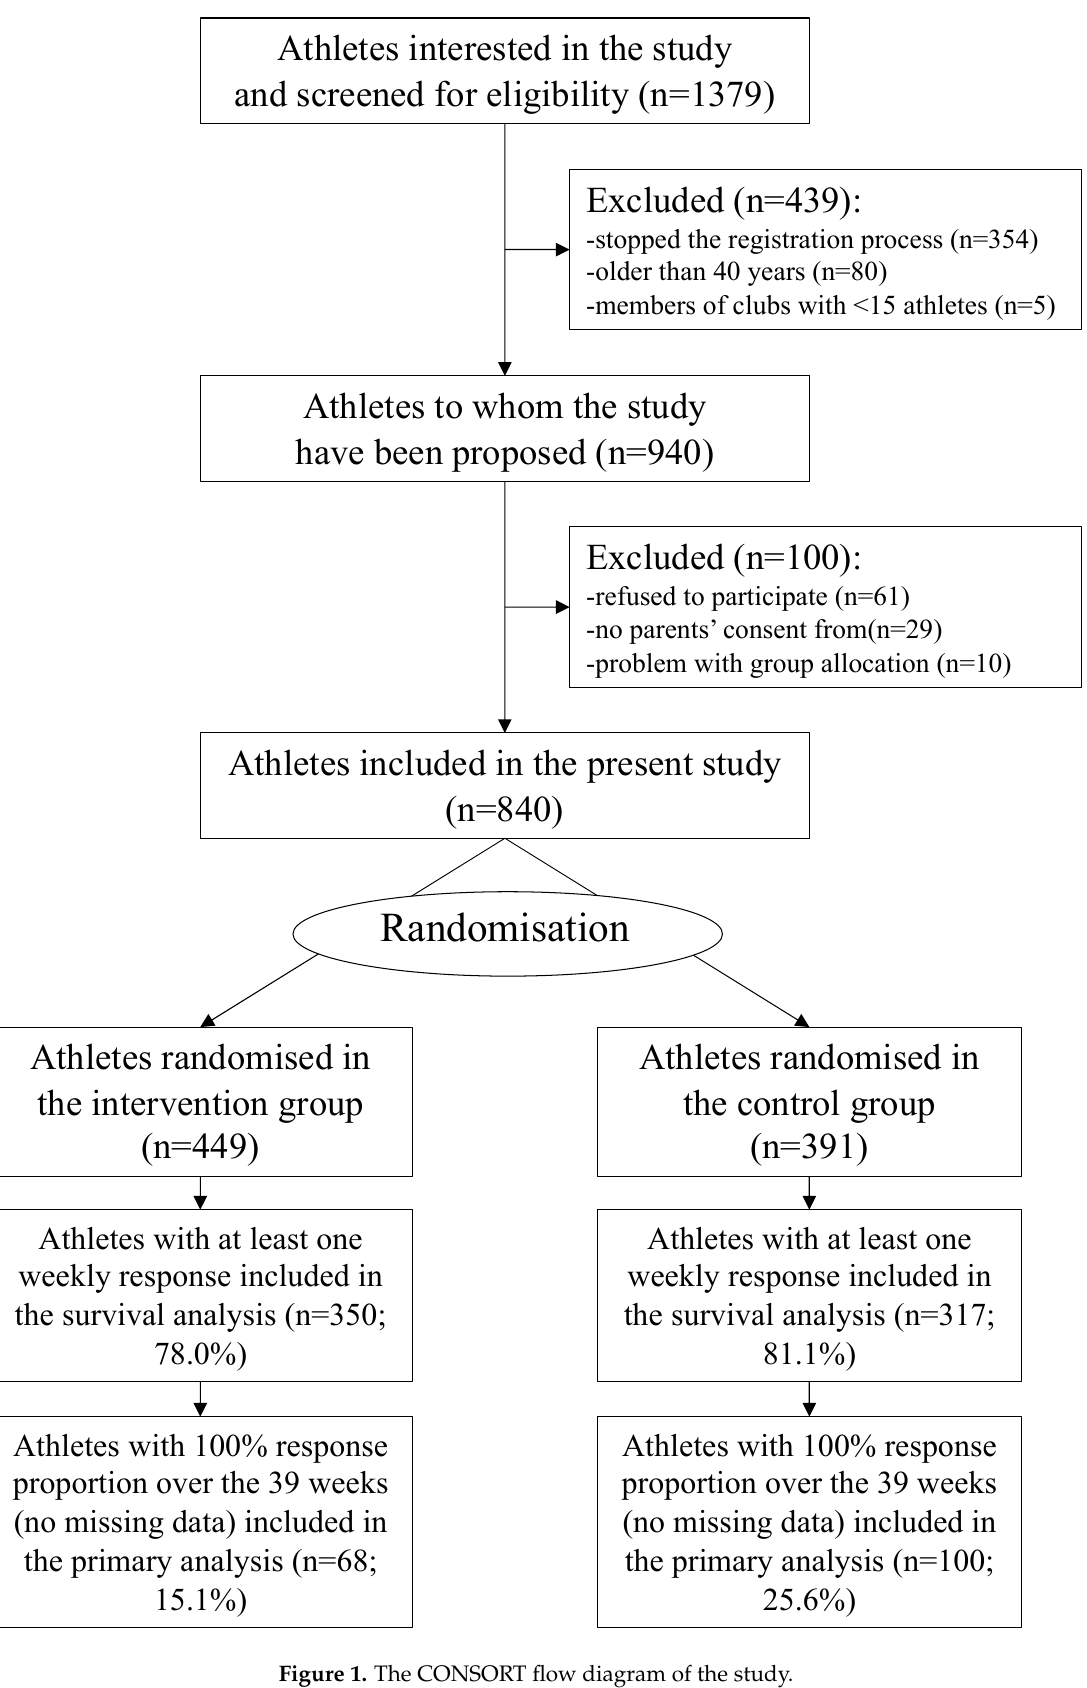
Figure 1. The CONSORT flow diagram of the study.